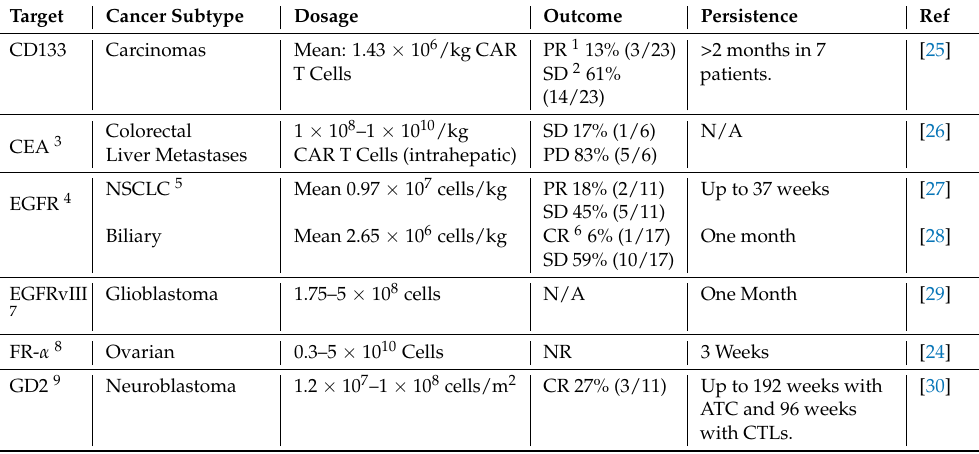
Table 1. Examples of published clinical trials of CAR T cells for the treatment of solid